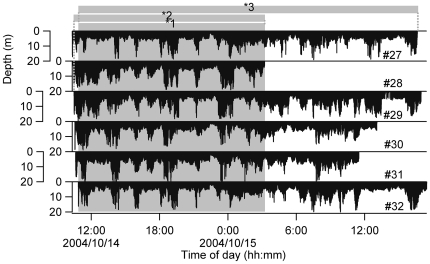
Overview of the dive profiles of the 6 finless porpoises.*1: the dataset used for testing the presence of true synchronized dives and testing partner choice by the 6 porpoises (16.4 h). *2: the dataset used for determining the identity of the initiator and follower for individuals #28 and #29 (16.7 h). *3: the dataset used for determining the identity of the initiator and follower for individuals #27 and #32 (29.7 h).